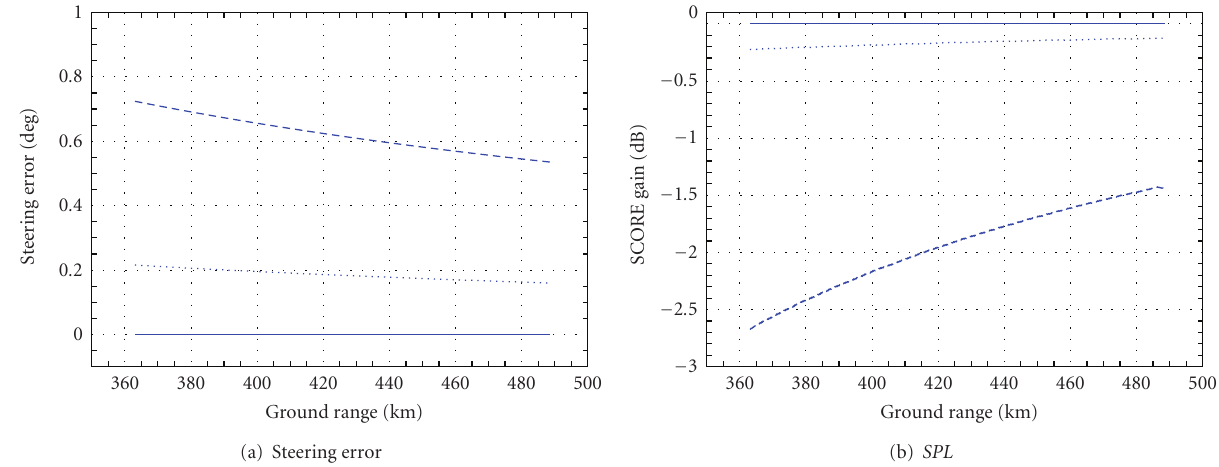
Figure 10: SCORE performance versus ground range for 0 m (solid line), 1500 m (dotted line), and 5km (dashed line) topographic height, respectively.